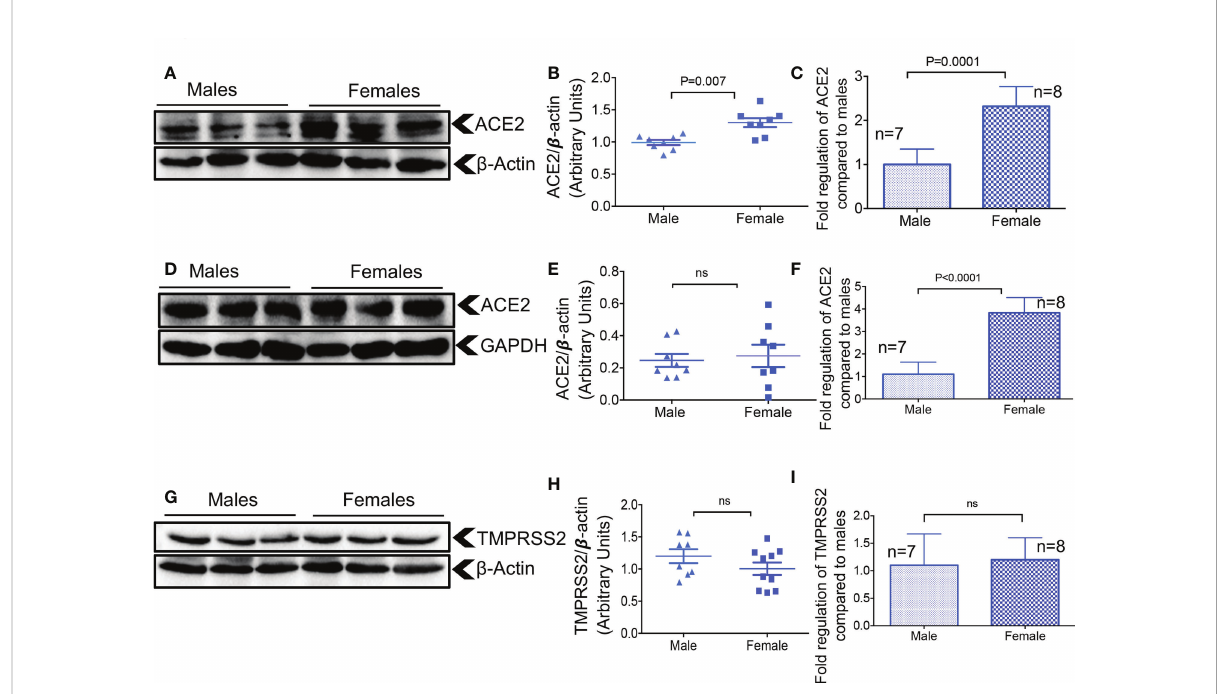
FIGURE 3 Elevated ACE2 at the gene and protein levels in the lungs of female mice. (A) Representative western immunoblots, and (B) cumulative data of ACE2 protein in the lung tissues of adult male and female mice. (C) Cumulative data showing fold regulation of ACE2 mRNA in the lung tissues of male versus female adult mice. (D) Representative western immunoblots, and (E) cumulative data of ACE2 protein in the heart tissues of adult male and female mice. (F) Cumulative data showing fold regulation of ACE2 mRNA in the heart tissues of male versus female adult mice. (G) Representative western immunoblots, and (H) cumulative data of TMPRSS2 protein in the lung tissues of male versus female older adult mice. (I) Cumulative data showing fold regulation of TMPRSS2 mRNA in the lung tissues of male versus female adult mice. All blots were repeated for reproducibility and lanes were loaded with equal amounts of protein. Quanti fi cation of ACE2 and TMPRSS2 normalised to the loading control. Error bars indicate mean ± SEM from at least two independent experiments. ns, Not signi fi